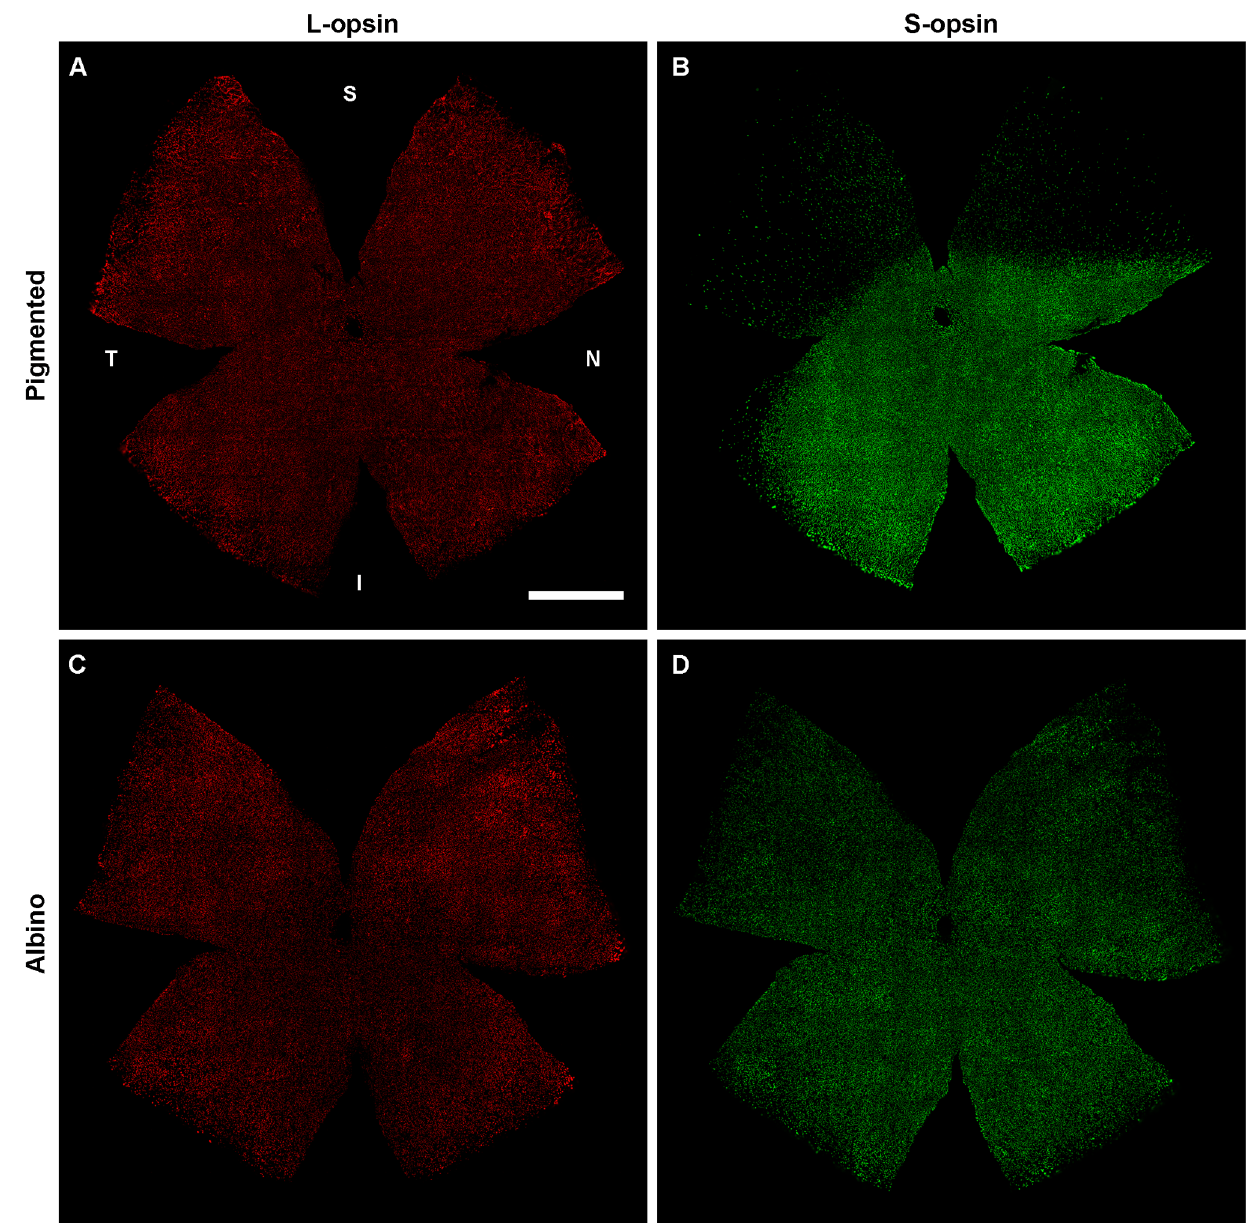
Figure 1. Opsin immunodetection in pigmented (C57/BL6) and albino (Swiss) mouse strains. Flat mounted left retinas from a pigmented ( A,B ) and an albino ( C,D ) mouse where the L- and the S- opsin have been double immunodetected. S: superior, N: nasal, I: inferior, T: temporal. Bar: 1 mm.